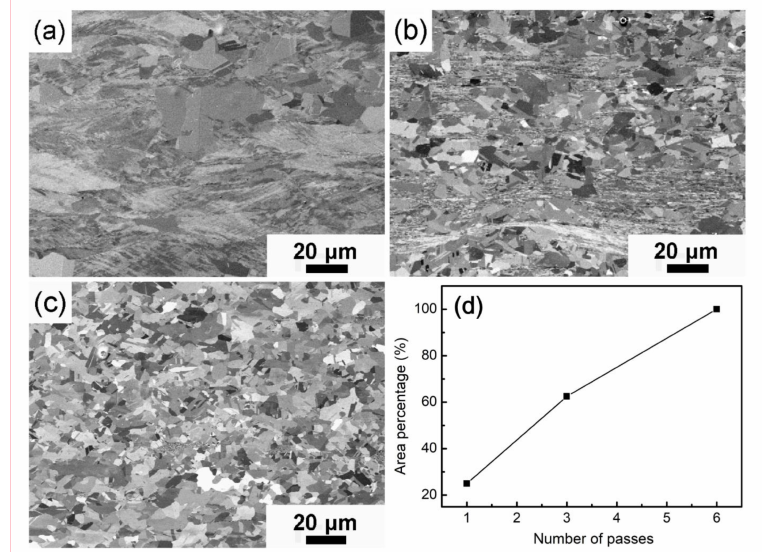
Figure 7. Microstructures of Cu ARBed for ( a ) 1 pass, ( b ) 3 passes, and ( c ) 6 passes after annealing for 60 min at 300 ◦ C, and ( d ) the area percentage of recrystallized